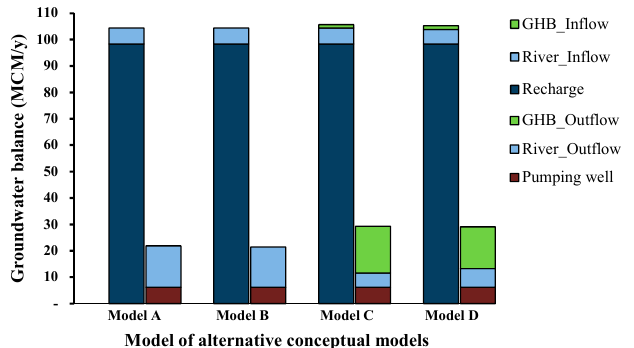
Figure 15. Inflow and outflow rates of aquifer balance in alternative hydrogeological conceptual models, 2010 ‒ 2015.